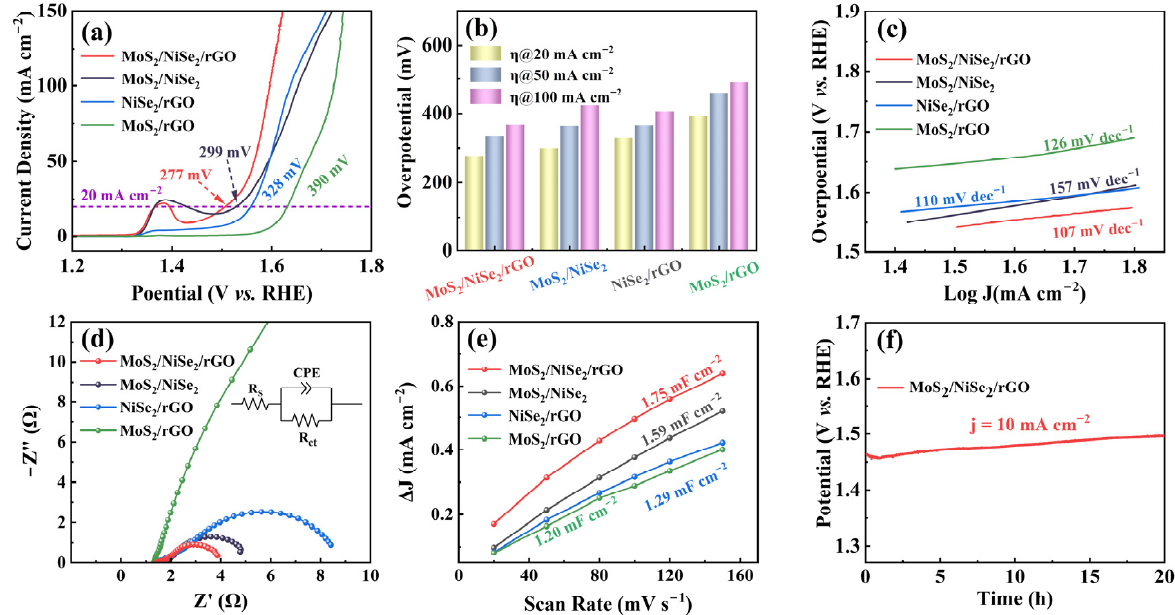
Figure 3. The OER performance of MoS 2 /NiSe 2 /rGO, MoS 2 /NiSe 2 , NiSe 2 /rGO, and MoS 2 /rGO in 1.0 M KOH solution. ( a ) Polarization curves (iR-corrected) at a scan rate of 2 mV s − 1 . ( b ) Overpotential required at a current density of 20, 50, and 100 mA cm − 2 . ( c ) Tafel plots. ( d ) Nyquist plots at an overpotential of 300 mV and fitted lines for an equivalent circuit. ( e ) The C dl values can be estimated from the linear slopes between ∆ j (=j anodic − j cathodic ) and scan rates. ( f ) Chronopotentiometry curve of MoS 2 /NiSe 2 /rGO with a constant current density of 10 mA cm − 2 .